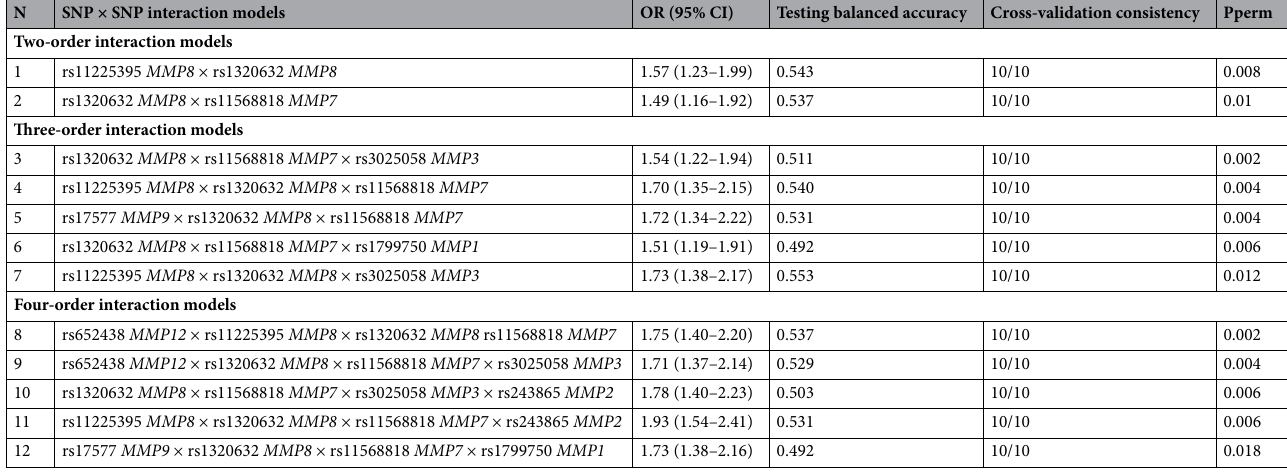
Table 5. Cross-validation statistics for best models of the gene–gene interactions in EH. Models are obtained using the multifactor dimensionality reduction method, version 3.0.2 CI , confidence interval, OR , odds ratio, Pperm , permutation P-value for the interaction model.